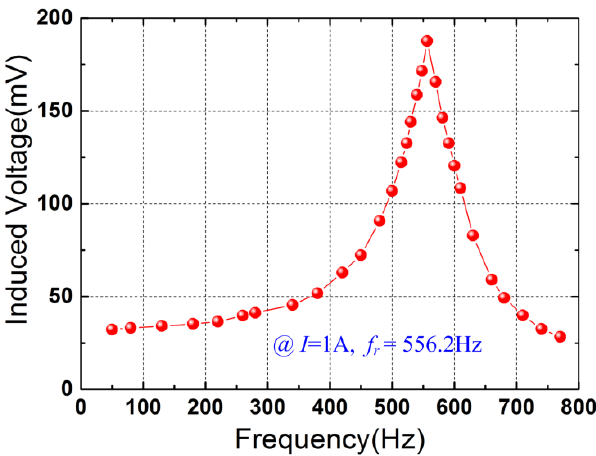
Figure 3. Induced voltage as a function of the current frequency at 1 A.